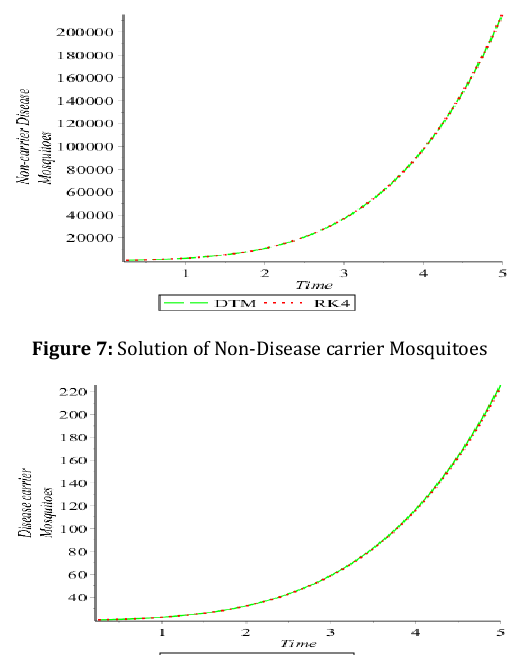
Figure 8: Solution of Disease carrier